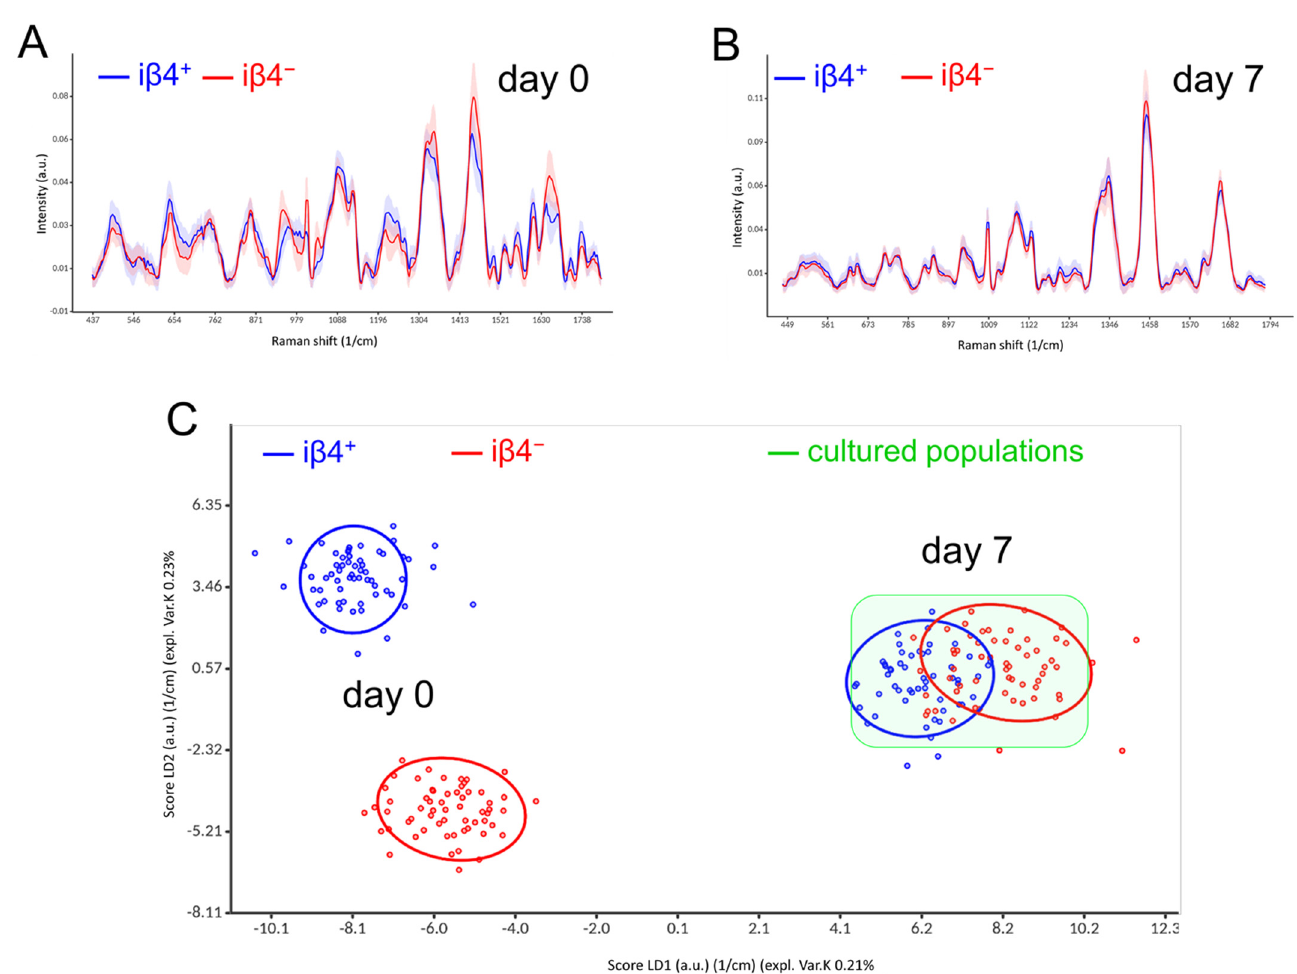
Figure 4. Raman spectroscopy suggests the relative phenotypical resemblance of basal and suprabasal cells after 2D culture. ( A , B ) Mean Raman spectra of i β 4+ (blue) and i β 4 − (red) cells just after sorting ( A ) or after 7 days of 2D culture ( B ). The shadings represent the standard deviation ( n = 60). ( C ) Score plot of the Linear Discriminant Analysis (LDA) revealing two distinct populations at day 0 (left) and overall, two spectrally identical populations at day 7 (right), which both completely differ from the original populations. Each dot represents a Raman measurement, and the ellipses describe 90% confidence interval. The green region underlines the similarity of the cultured keratinocyte populations.